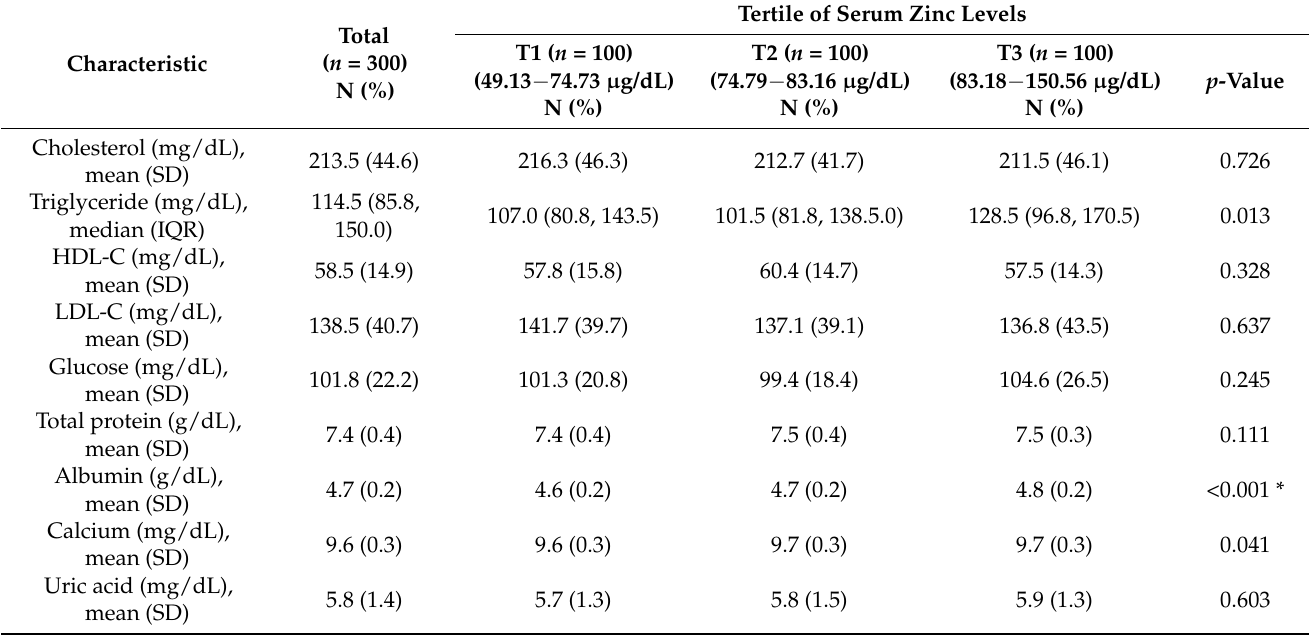
Table 2. Biochemical parameters of the participants classified by the tertile of serum zinc